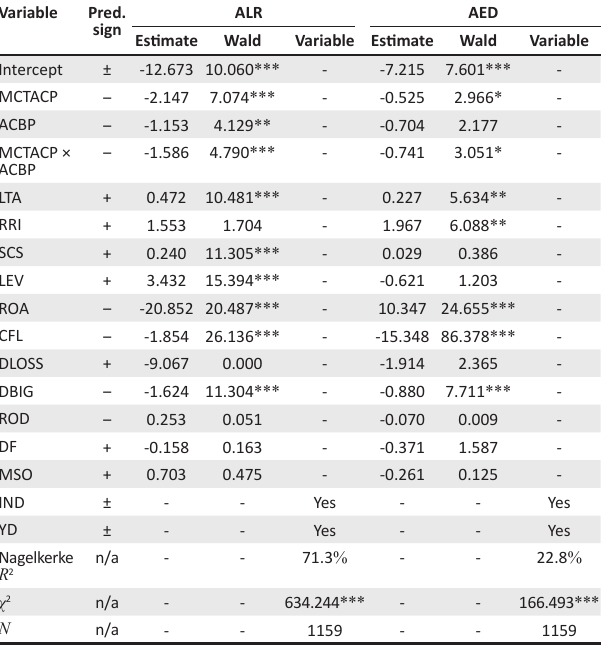
TABLE 5: Logistic regression of the achievement of earnings goals on audit committee compensation and audit committee compliance with best practices: Equation